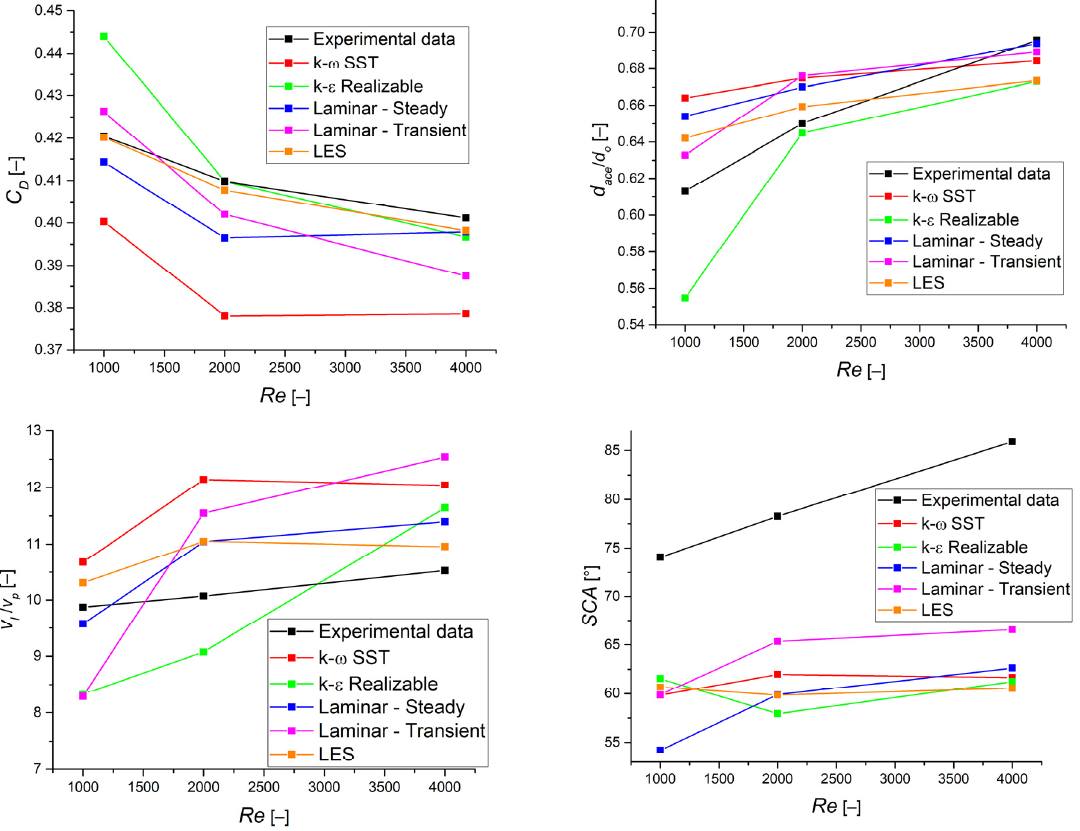
Figure 10. Effect of Re on C D , SCA , liquid sheet velocity, v l , and d ace from various numerical setups. Table 4. Comparison of different physical models, 3D periodic mesh with port, Re = 2000.